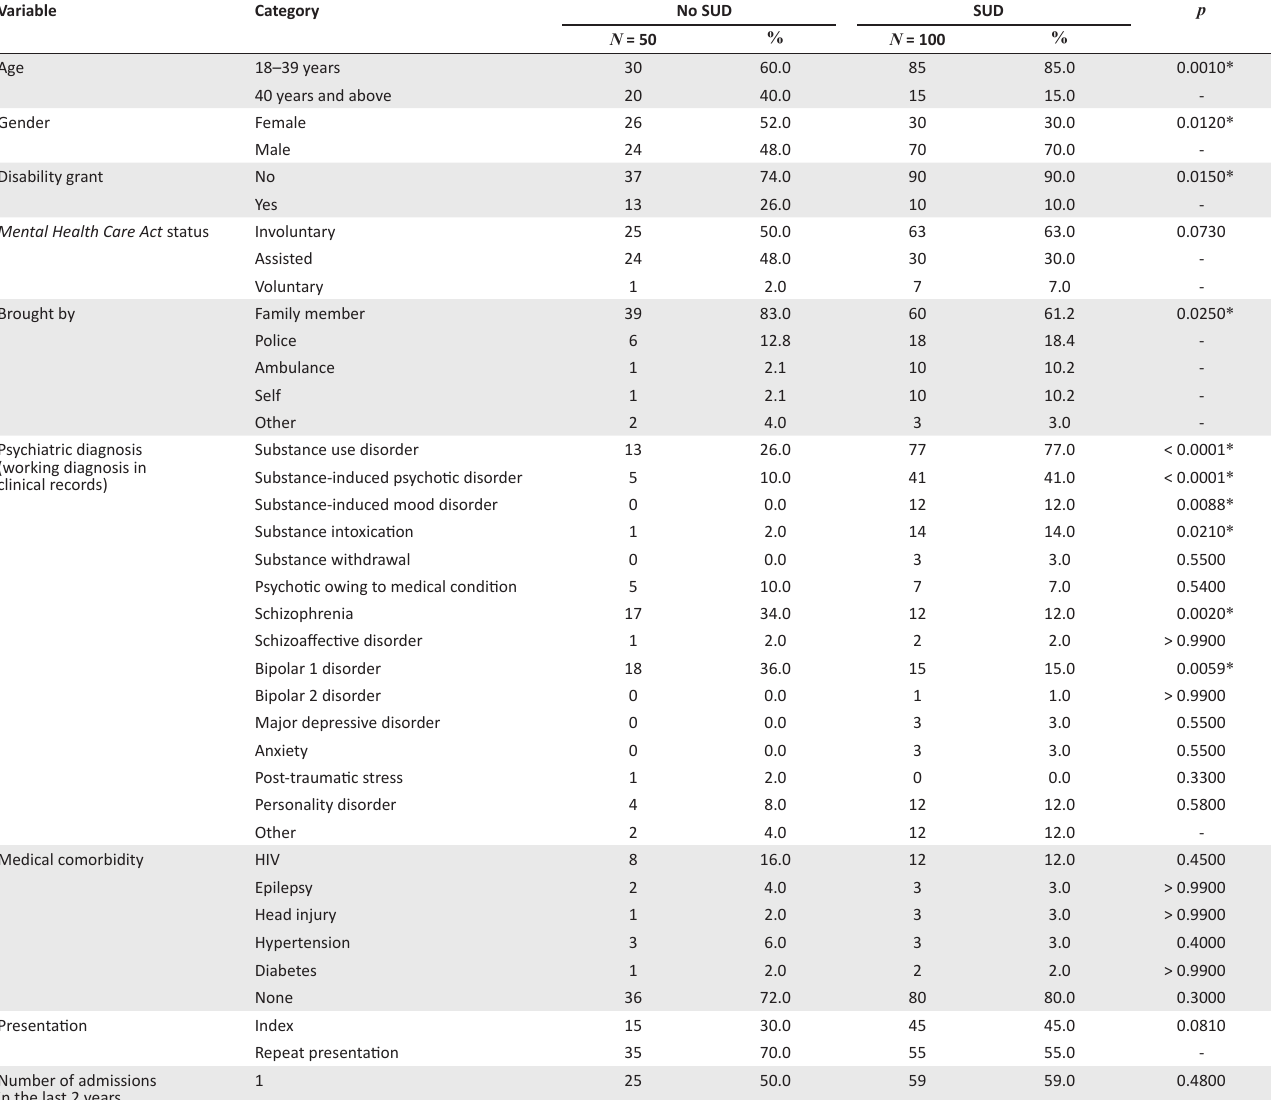
TABLE 4: Comparison of characteristics between those without and with substance use disorders on alcohol use disorders identification test and drug use disorders identification test.